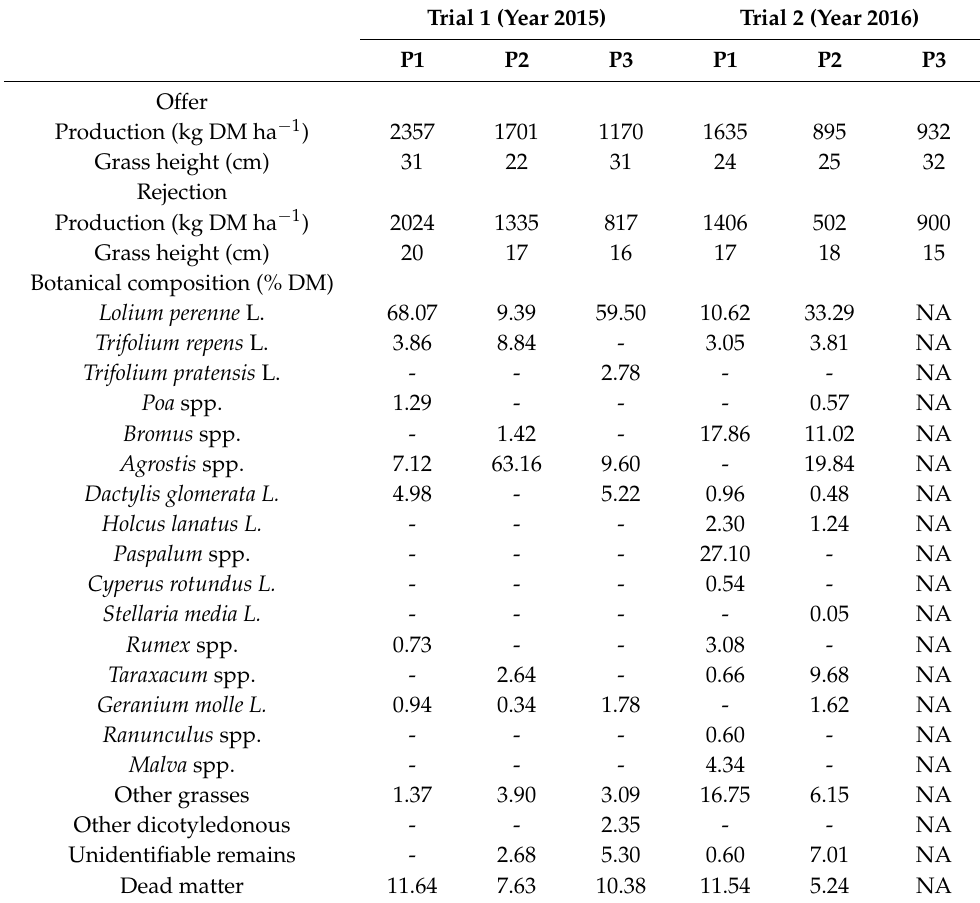
Table 3. Meadow characteristics used in grazing dairy cows in each period of the feeding trials carried out.